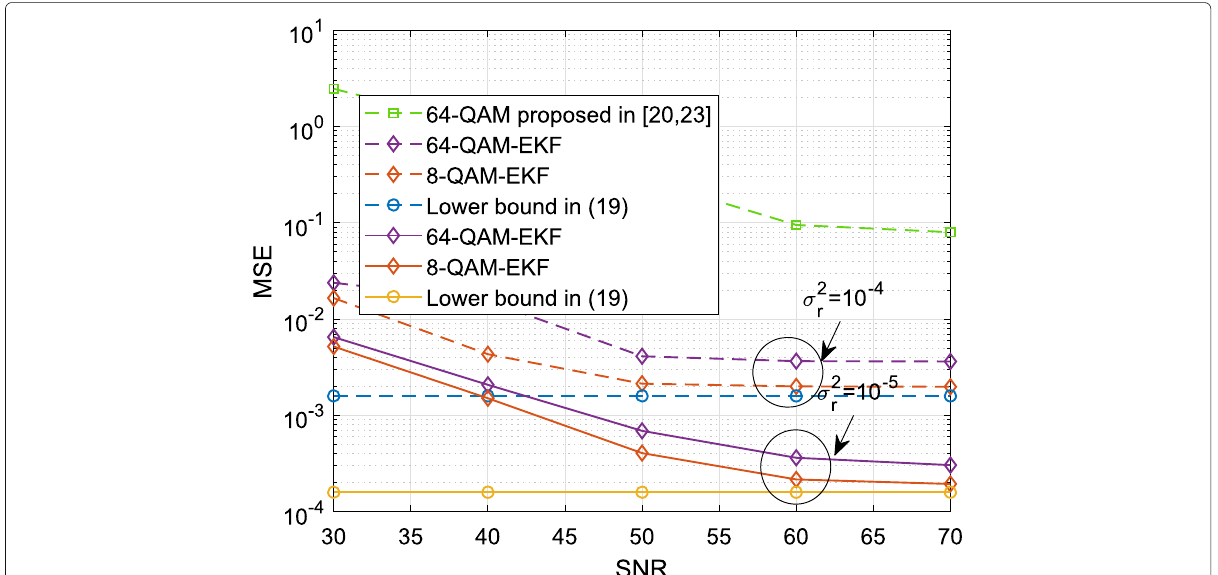
= 10 − 4 ,10 − 5 and different QAM modulations for a 2 × 2 FD MIMO system with SIR = 0 SI